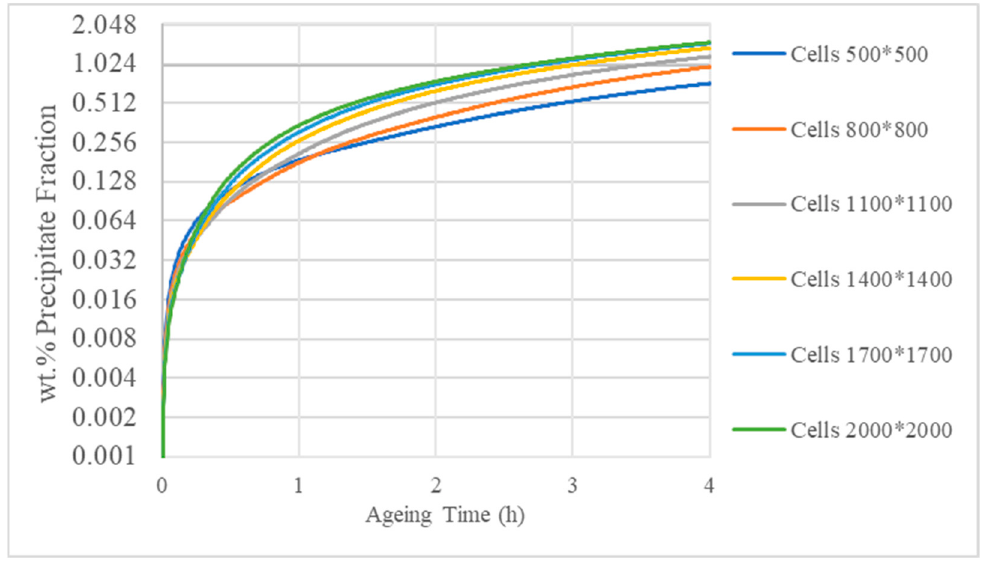
Figure 7. Mesh analysis of 220 °C-4 h ageing treatment for Al-0.9M-0.6Si ternary system.